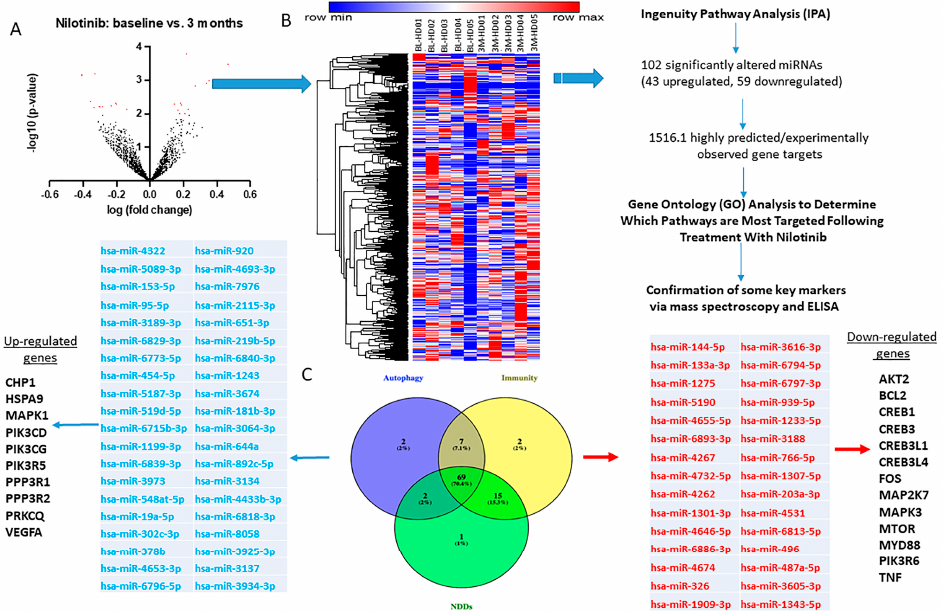
Figure 2. Treatment with nilotinib results in differential miRNA expression. ( A ) Volcano plot showing differentially regulated miRNAs following 3 months of treatment with nilotinib; miRNAs with a − log 10 p -value > 2 are displayed in red (significance: p < 0,05). ( B ) Processing of sequenced miRNAs; miRNAs were analyzed to look for significant alterations in expression using Ingenuity Pathway Analysis (IPA), which revealed 102 distinct miRNAs that targeted 15,161 genes. ( C ) Gene ontology analysis revealed that autophagy, immunity, and neurodegenerative disease pathogenesis were the pathways most targeted by both up and downregulated miRNAs following nilotinib treatment, identifying a series of genes associated with these pathways that are targeted by selected